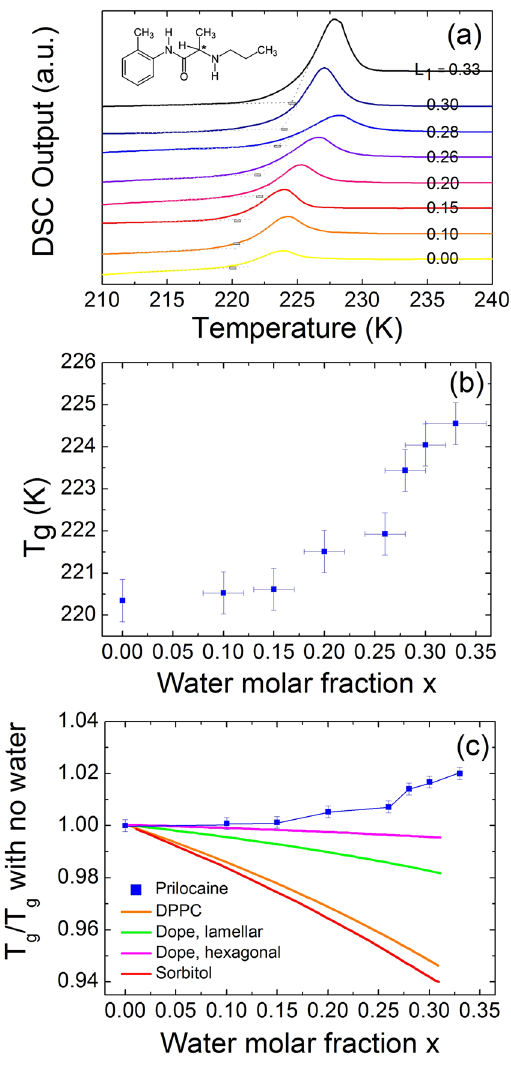
Figure 1. Effect of water on the glass transition temperature. ( a ) DSC scans for different water molar fractions x of binary prilocaine/water mixtures, measured upon heating at 8 K/min right after aging during 1 hour at 215.2 K. Inset: molecular structure of prilocaine. ( b ) Onset T g values for prilocaine as a function of water concentration (data corresponding to the thermograms in ( a )). ( c ) Normalized glass transition temperatures for binary water-solute systems. Prilocaine: this work. T g values for other systems are described with the Gordon-Taylor equation (see Supplementary information) based on the T g values reported for sorbitol and for phospholipids DPPC (1,2-dipalmitoyl-sn-glycero-3-phosphocholine) and DOPE (1,2-dioleoyl-sn-glycero-3- phosphatidylethanolamine). The corresponding parameters of the Gordon-Taylor equation are provided in Table S1 of the Supplementary